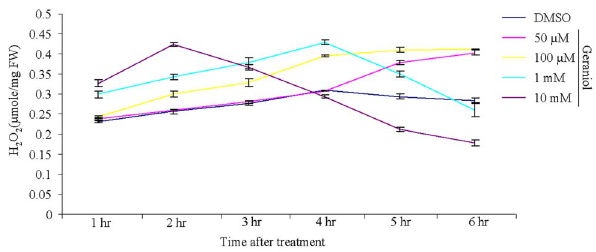
Figure 6. H 2 O 2 concentration measured in tomato seedlings after treatment with geraniol. Seedlings were placed in MS media containing geraniol (50 m M to 10 mM) or 20% DMSO (control). Data are mean 6 SEM